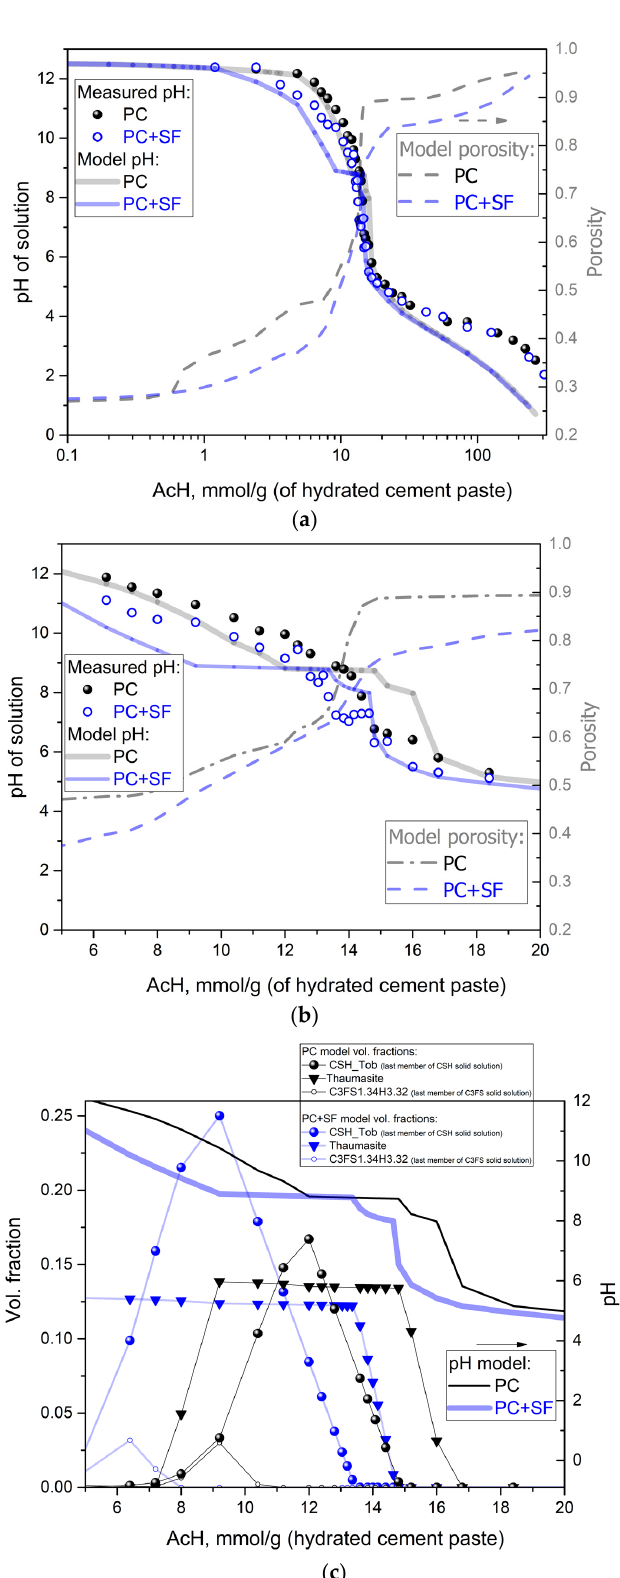
Figure 2. Change of pH as a function of acid concentration: full range of acid concentration ( a ) and zoom-in inset ( b ). The shape of the predicted pH is related to the dissolution ( c ), indicating a decrease in the vol. fraction of solid solutions and Thaumasite.